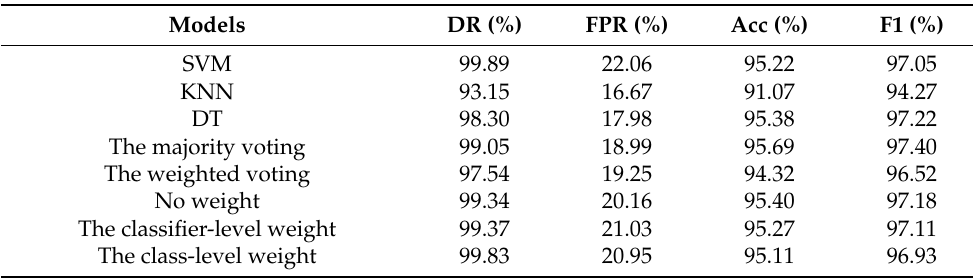
Table 6. Performance comparisons of the base learners and different voting ensemble methods without feature selection on the UNSW-NB15 dataset.